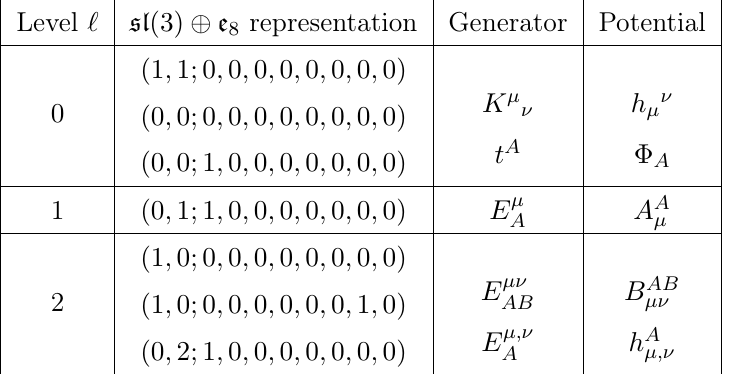
Table 7 . Level decomposition of e 11 under its gl (3) (cid:8) e 8 subalgebra obtained by deleting node 3 from the Dynkin diagram in figure 1, up to level ‘ = 3 . The Dynkin labels for the two summands are separated by a